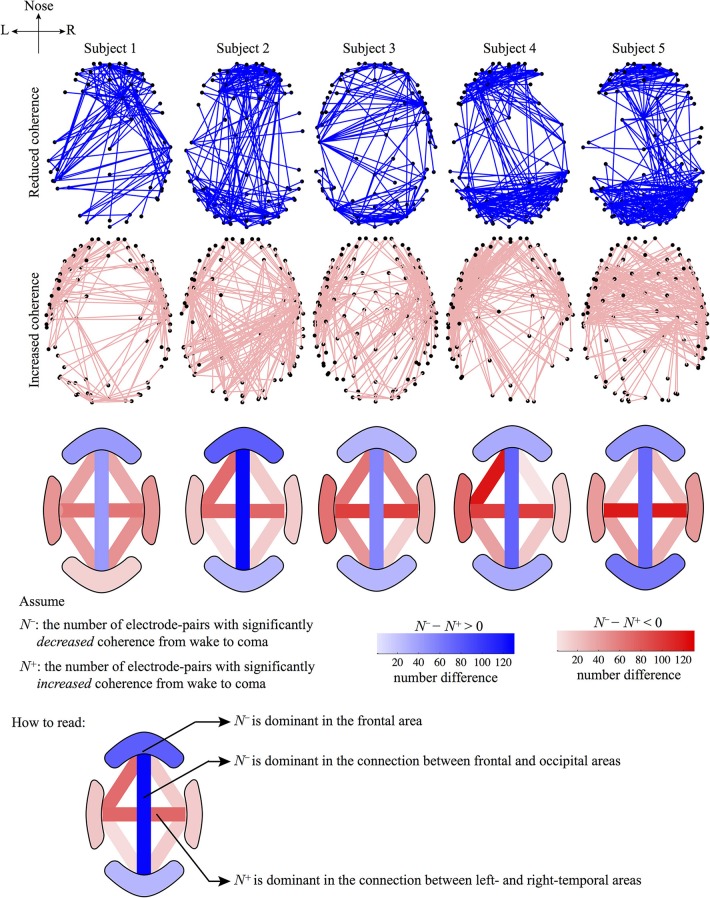
Graphical representations of the electrode-pairs with significantly altered coherence from wake to coma for five subjects. The first and second rows represent electrode-pairs with significantly reduced (blue lines) or increased (pink lines) coherence, respectively: selected electrode-pairs correspond to the top 5% most changed (i.e., most increased or most decreased) coherence during the wake to coma transition. The third row describes the number difference of electrode-pairs between the first and second rows for four regions: frontal, occipital, left- and right-temporal; and for six pair-wise connections between regions: frontal–left temporal, frontal–right temporal, frontal–occipital, left temporal–occipital, right temporal–occipital, left–right temporal. The number of electrode-pairs with significantly reduced (or increased) coherence in a region is counted as N− (N+). The sign of (N− − N+) determines the dominance of a coherence trend: if (N− − N+) > 0, the region will be colored blue (decreased coherence); otherwise if (N− − N+) < 0, the region will be colored red (increased coherence). The (N− − N+) difference is calibrated by the color-gradient bar. (Note that the color-bar for the third row is not related to the first and second rows.)